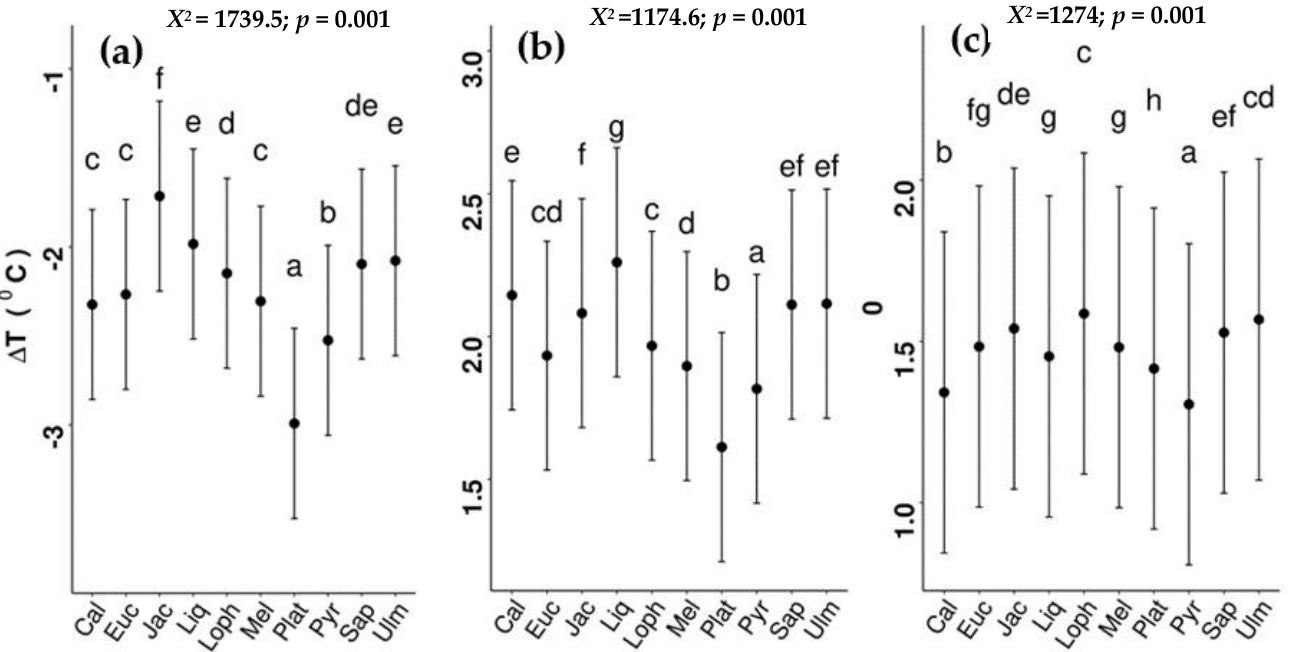
Figure 4. Species differences in ∆ T ( a ) in the morning (07:00 to 13:00), ( b ) in the afternoon (15:00 to 19:00), and ( c ) at night (01:00 to 05:00). Different letters indicate significant differences at p < 0.05. The black points indicate mean values ( ± SE). For abbreviations of species names and number of replicates see Table 1. Chi-square (X 2 ) and p values for each of the lmer models are given in the figures. Analysis of variance (ANOVA) results of lmer models for each plot are in Supplementary Table S1.